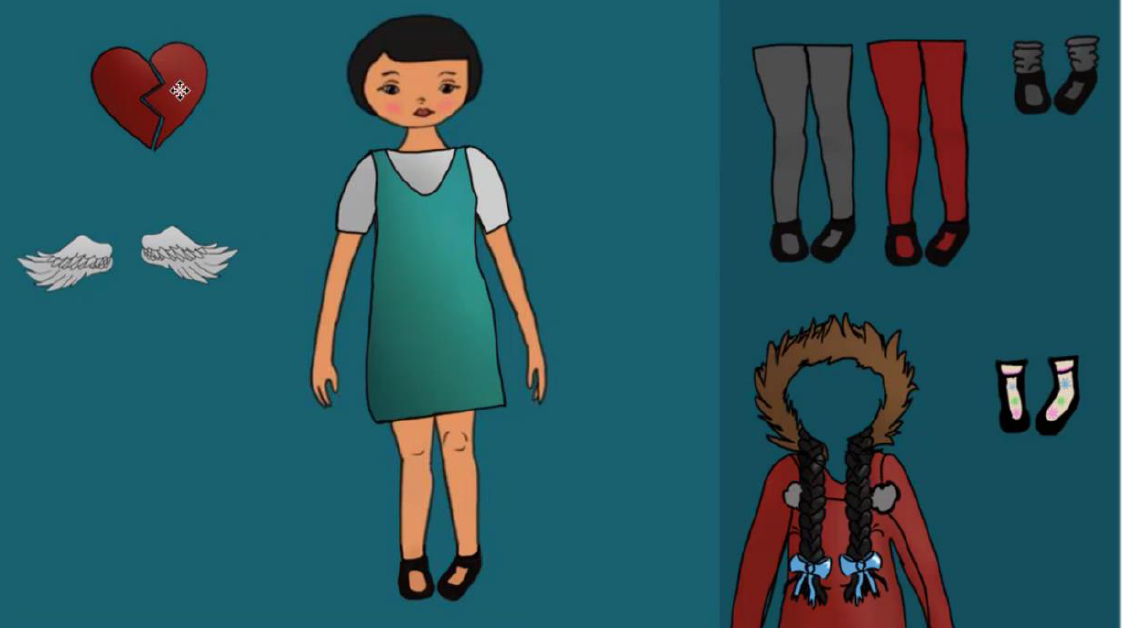
Figure 7 : A free downloadable teachers’ resource from Christy Jordan - Fenton’s website where students may dress Margaret in traditional clothing or in the stockings residential schoolteachers used to shame her.